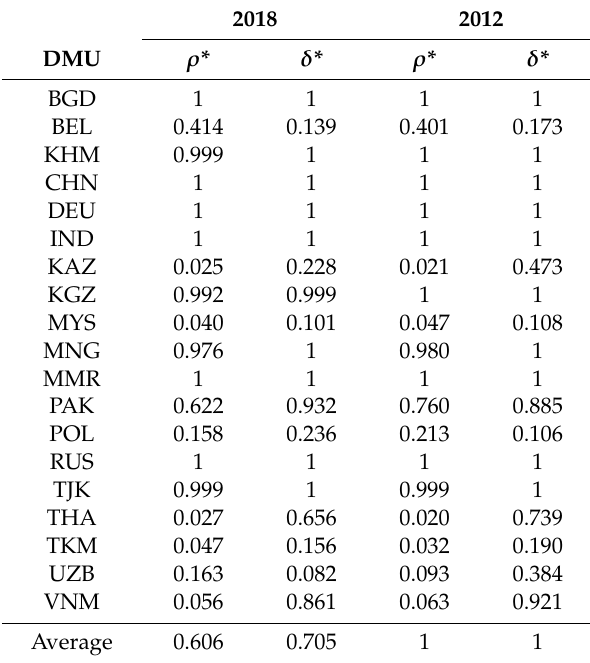
Table 7. The transport energy e ffi ciency score of BRI corridor countries in 2012 and 2018.